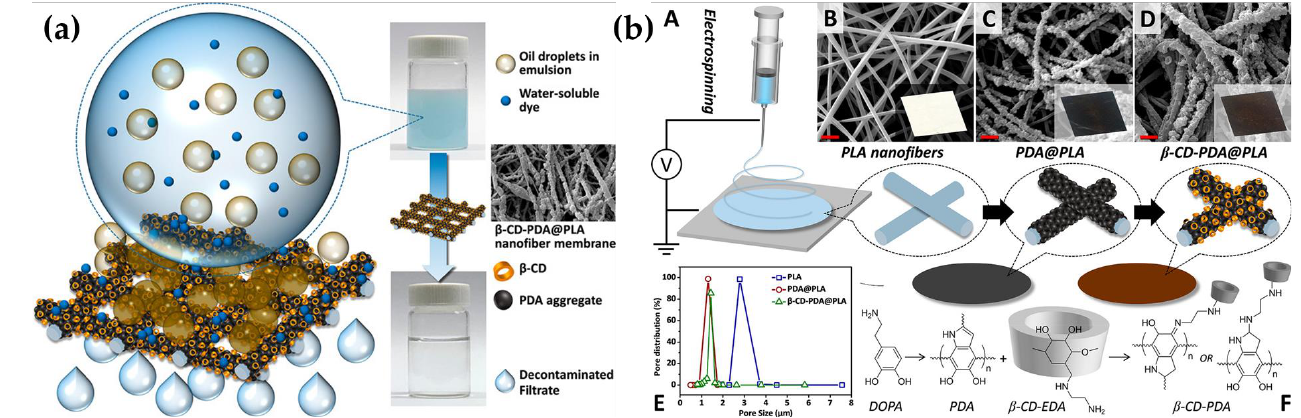
Figure 11. Oil-in-water separation features of the β -CD-PDA@PLA electrospun nanofiber mem- brane ( a ). Schematic representation of the electrospinning of the nanofiltration membrane based on β -CD-PDA@PLA (A); images of the PLA NF membrane (B), PDA@PLA NF membrane (C), β -CD-PDA@PLA NF membrane (D) taken with a camera and SEM (scale bars denote 2 µm); distribution of NF membrane pore size (E); CD-PDA@PLA NF membrane synthesis pathways (F) ( b ). Reproduced with permission from ACS Sustainable Chem. Eng.; published by ACS Publications, 2018